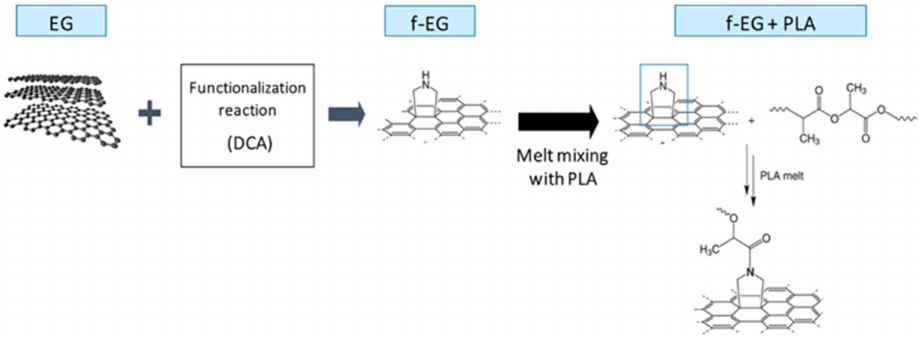
Figure 3. Schematic representation of the EG functionalization by the DCA reaction, obtaining f-EG as well as its further interaction with PLA under melt processing